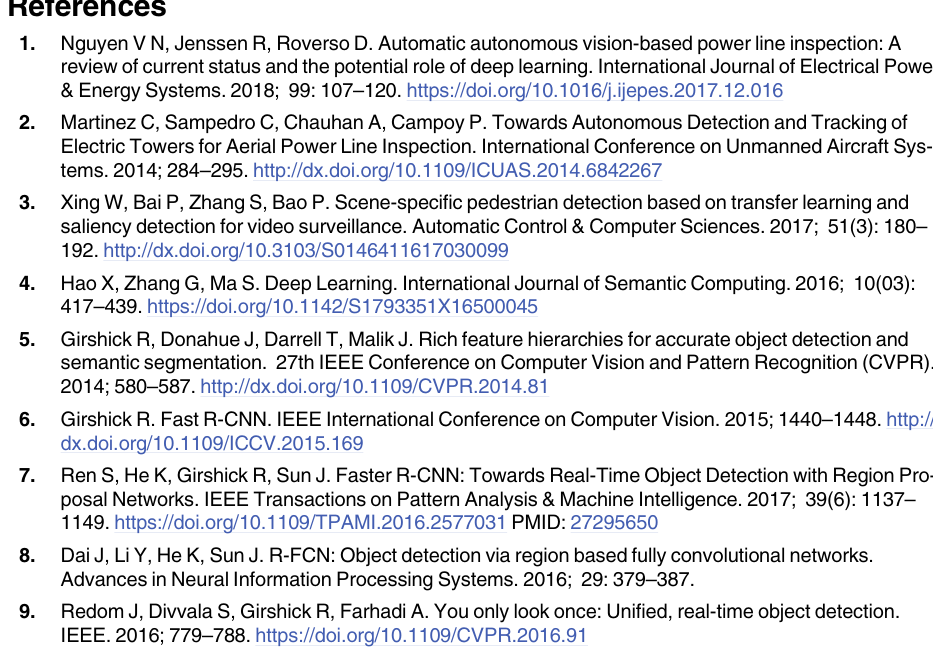
Fig 10. The visual effects of different methods of testing results. From top to bottom are the visual results of Faster R-CNN, YOLOv3, RetinaNet, FSAF and our proposed